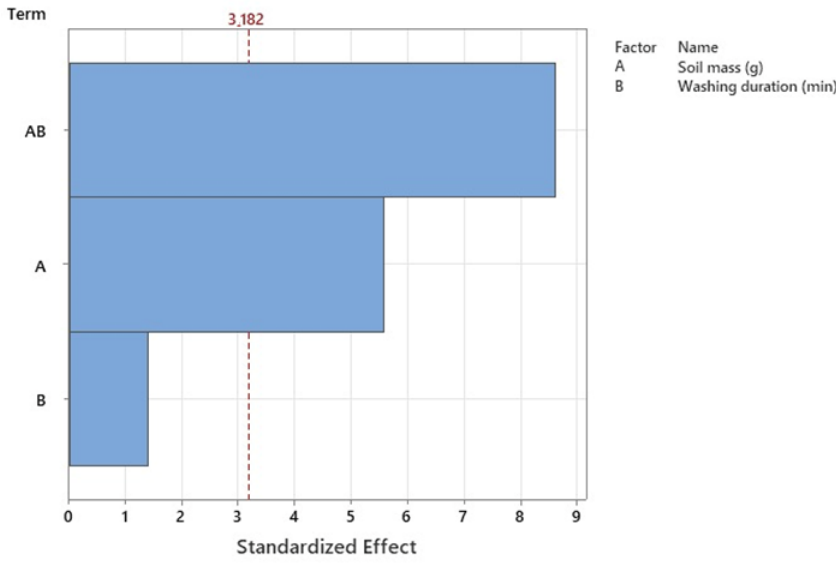
Figure 7. Pareto Chart of the standardized effects of Soil mass and Washing duration on the oil removal (%).